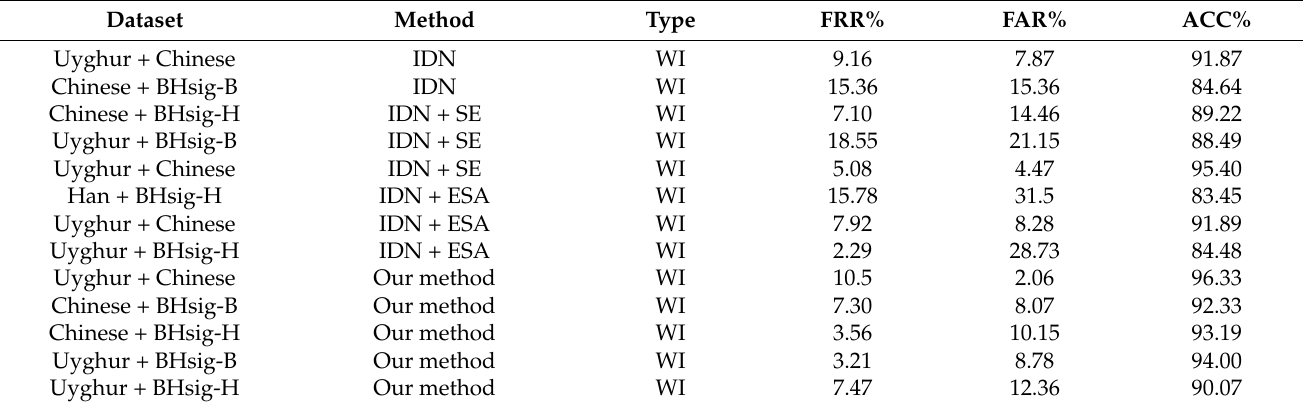
Table 4. Signature verification results and comparative experiments of open data sets.